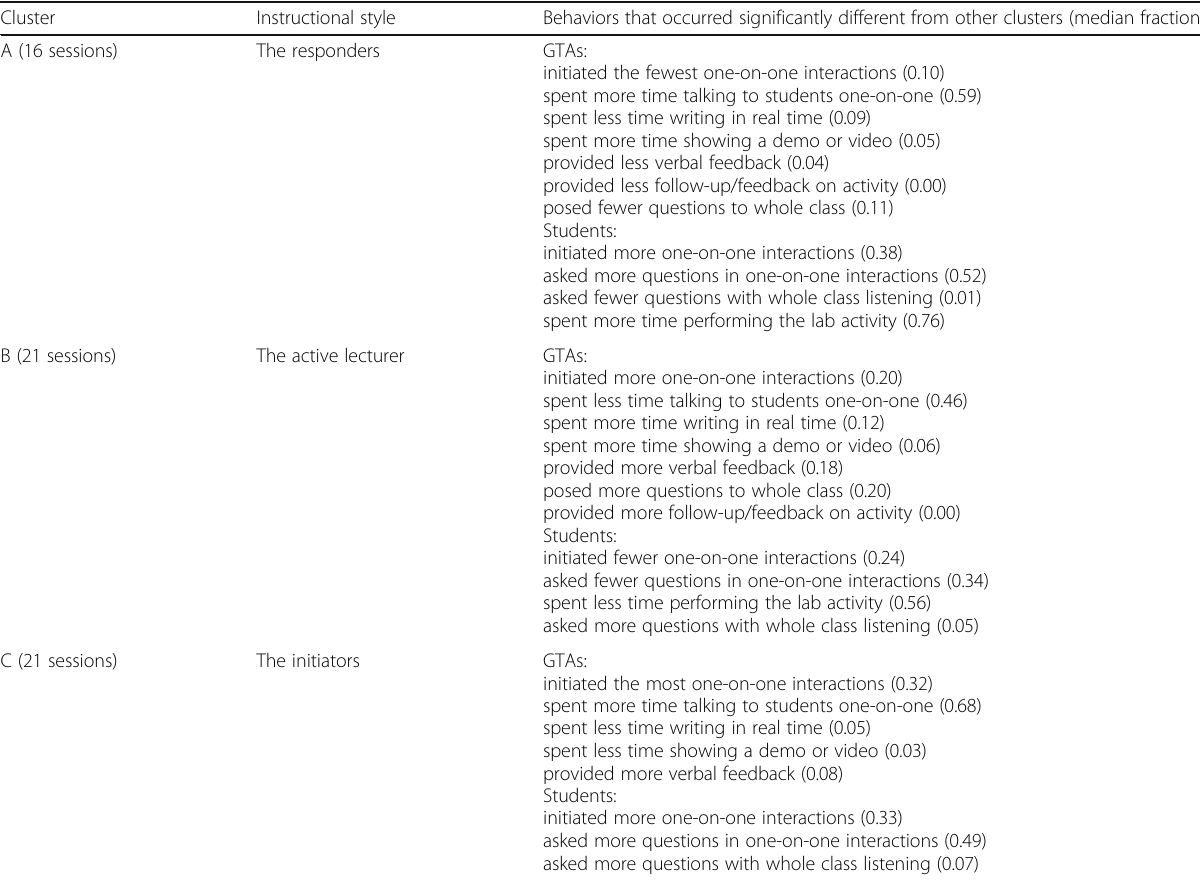
Table 4 Characteristics of chemistry GTAs ’ instructional practices in each cluster